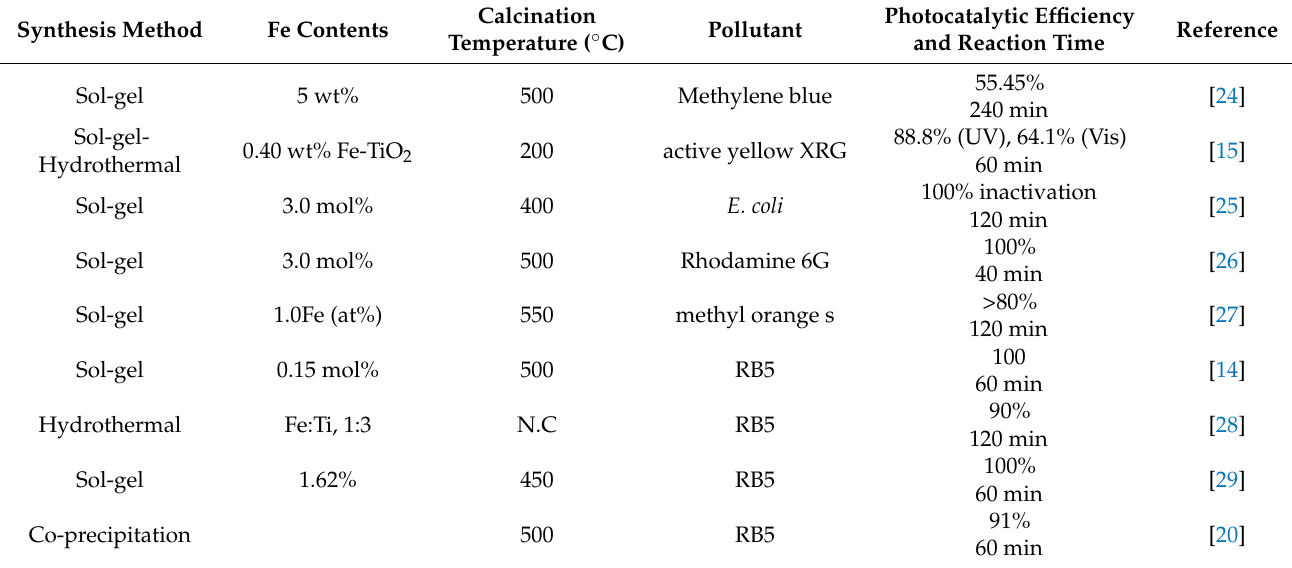
Table 1. Comparative studies with Fe doped TiO